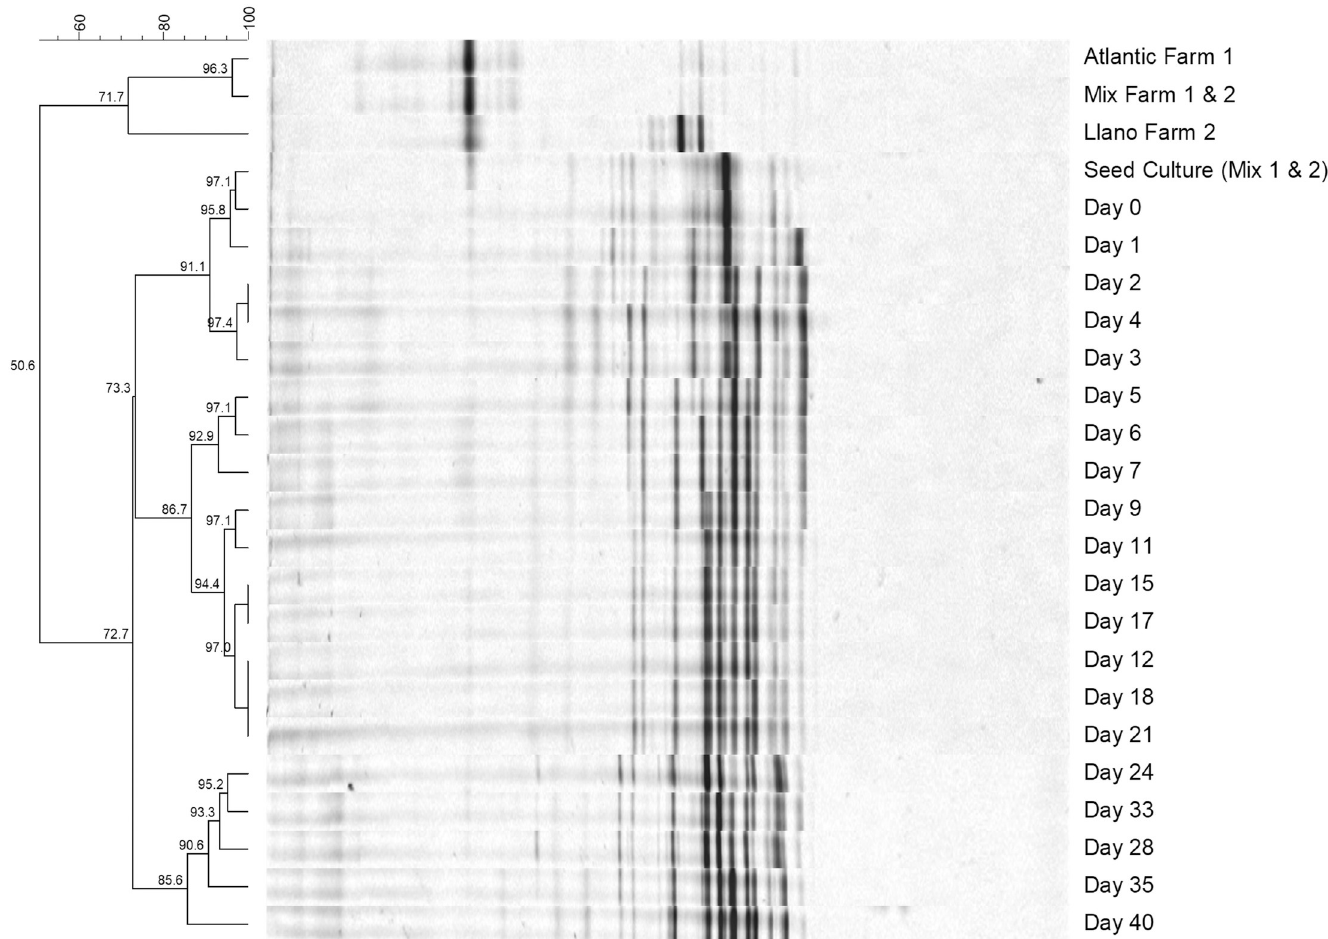
Fig 7. Denaturing gradient gel electrophoresis (DGGE) profiles of PCR-amplified bacterial gene fragments for the farms (Atlantic and Llanos) and the continuos-flow competitive exclusion derived from Nile tilapia ( Oreochromis niloticus ) gut microbiomes.